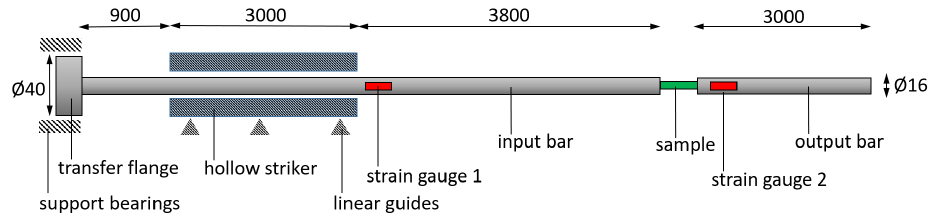
Figure 2. Sketch of the SHTB setup employed in this work. All dimensions are in